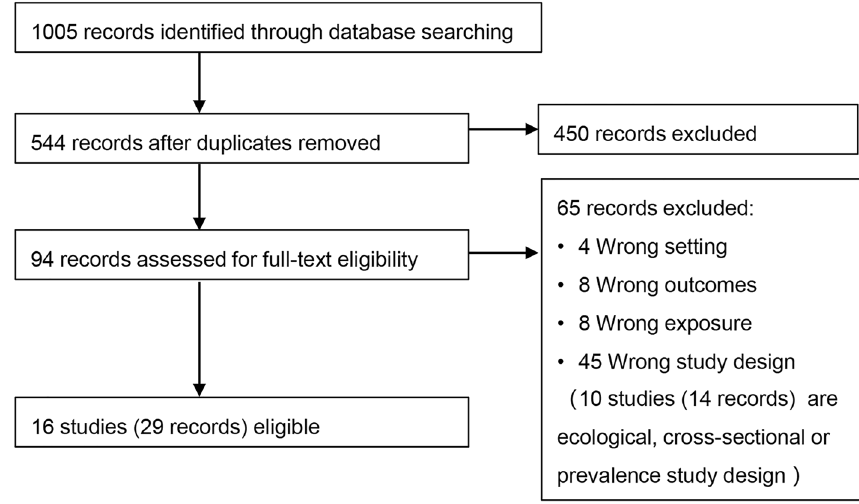
Figure 1. Flow diagram of included